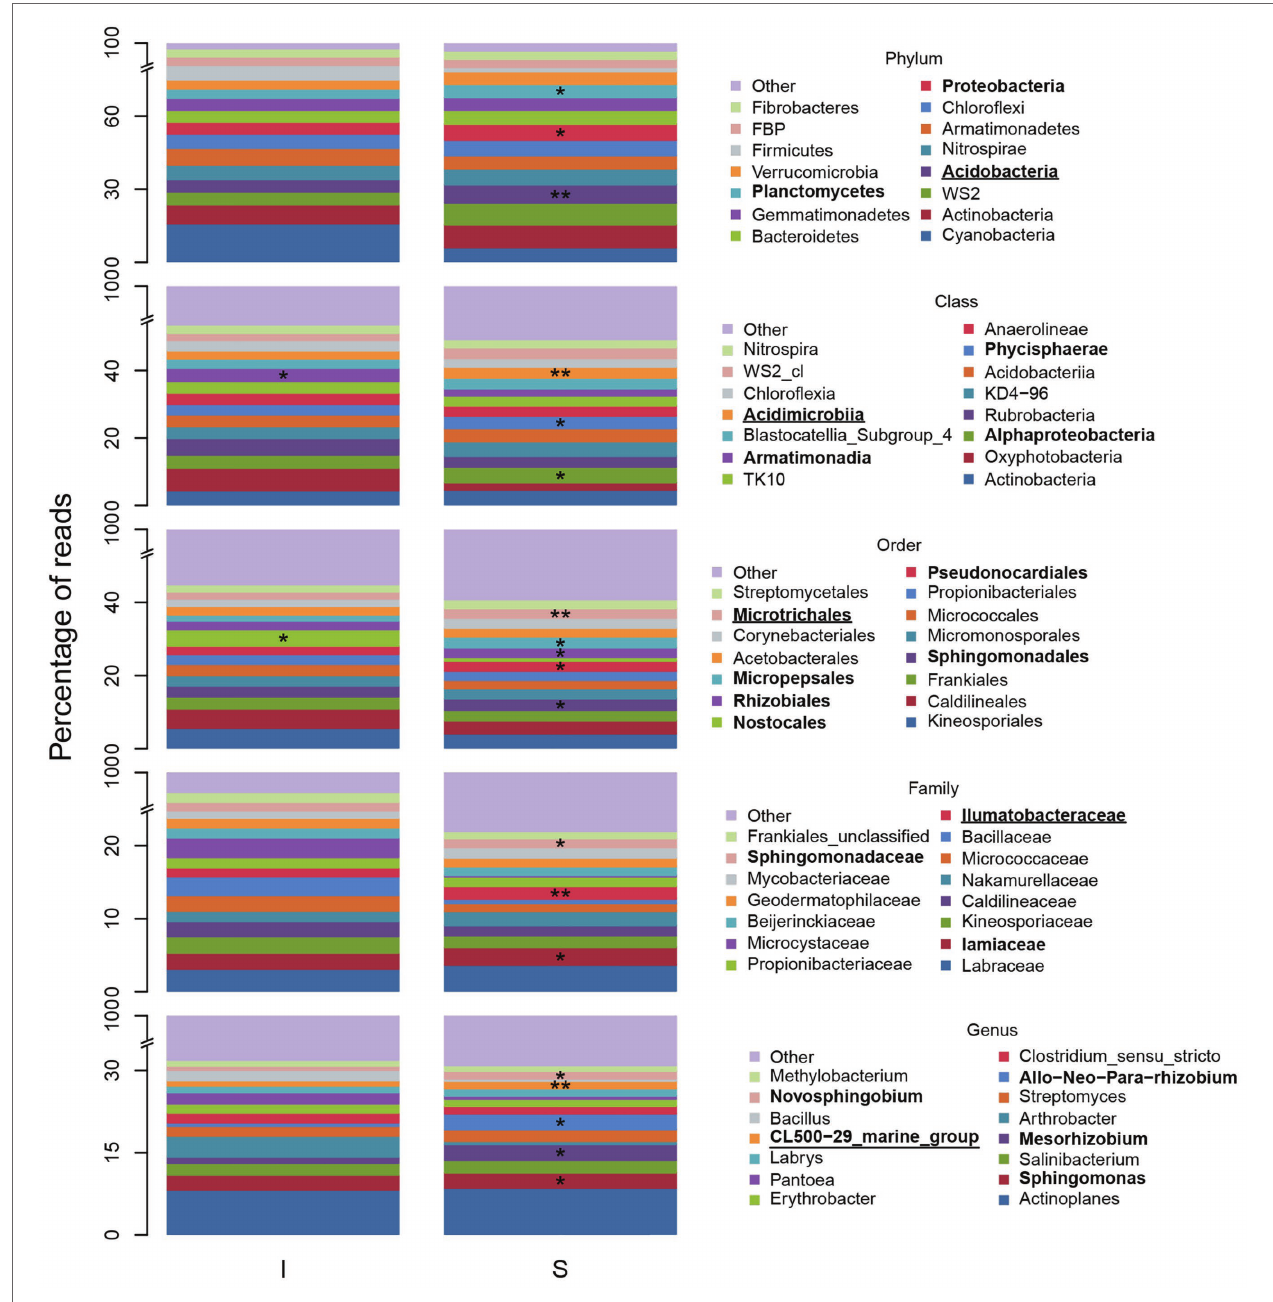
FIGURE 7 | Fifteen most abundant BSC bacterial taxa and indicators, at varying levels, understory shrubs (S) or in intershrub spaces (I). The “other” category comprises all other less abundant taxa and “unclassified” and “uncultured” groups. Allorhizobium - Neorhizobium - Pararhizobium - Rhizobium was abbreviated. Asterisks (*) denote a significant ISA taxon and are accompanied by bold font entries in the legend. Double asterisks (**) denote a significant ISA taxon after controlling for FDR and are accompanied by bold text and underlined entries in the